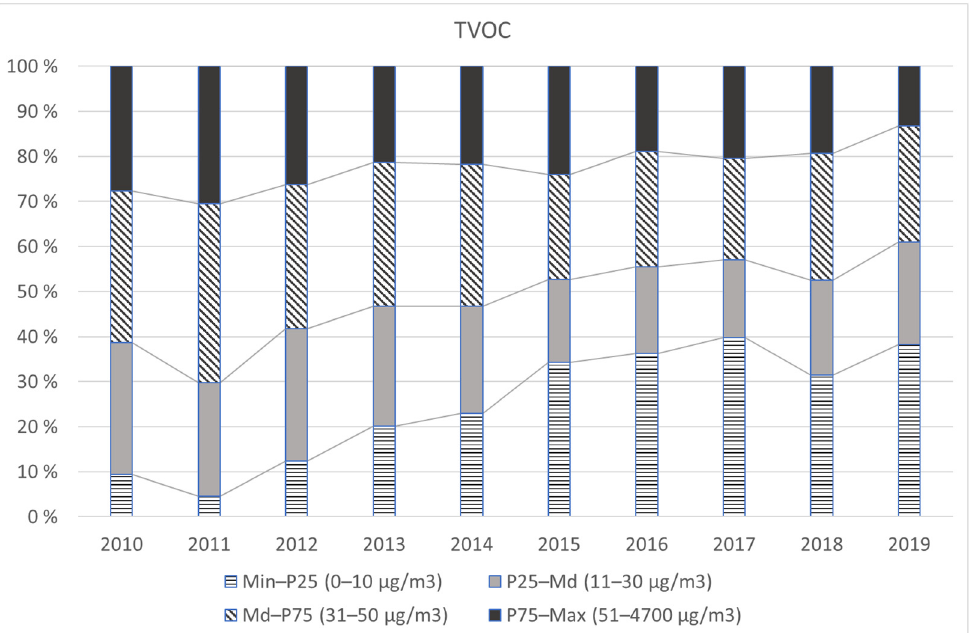
Figure 1. The shift in TVOC distribution in 2010–2019. The four different colour patterns represent the four quarters between the data points of Min, P25, Md, P75, and Max of the ten-year TVOC data ( n = 9789). It can be seen from the graph that the share of the first quarter (Min–P25) increased and that the share of the top quarter (P75–Max) decreased during the study period.